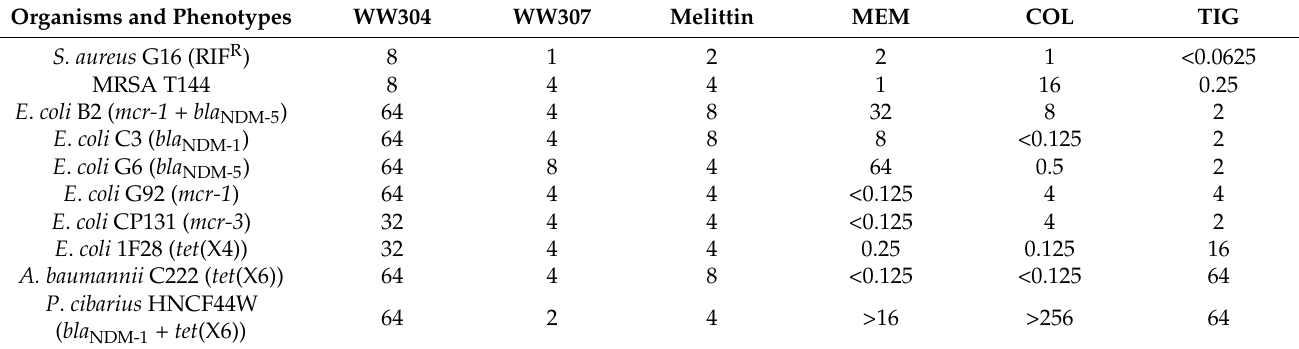
Table 2. Antimicrobial activity of amphiphilic peptides against a panel of MDR pathogenic bacteria (MIC, µ g/mL). Organisms and Phenotypes